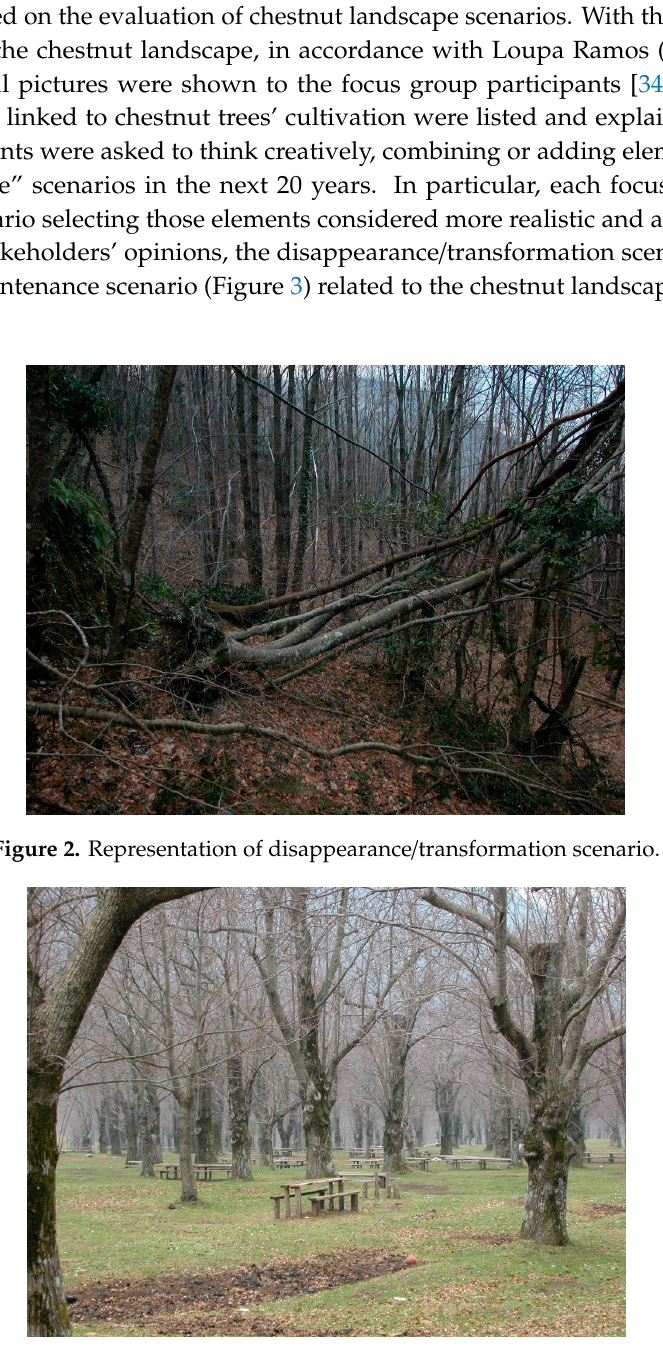
Figure 3. Representation of permanence/maintenance scenario.